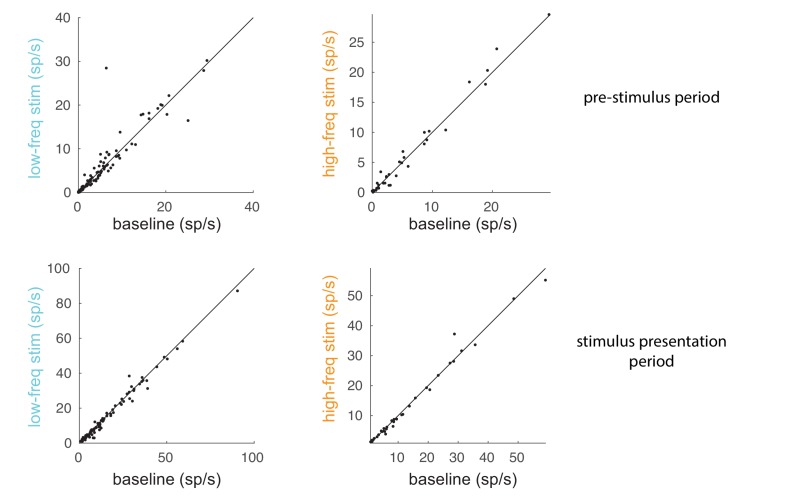
Comparison of spike rates between baseline and optical stimulation.Comparison of spike rates between the optical stimulation conditions (low-frequency: left panels; high-frequency: right panels) and the baseline condition for a 200 ms pre-stimulus period (top panels) and 200 ms stimulus presentation period (60–260 ms after stimulus onset; bottom panels). Each dot represents a unit in the population of recorded units.